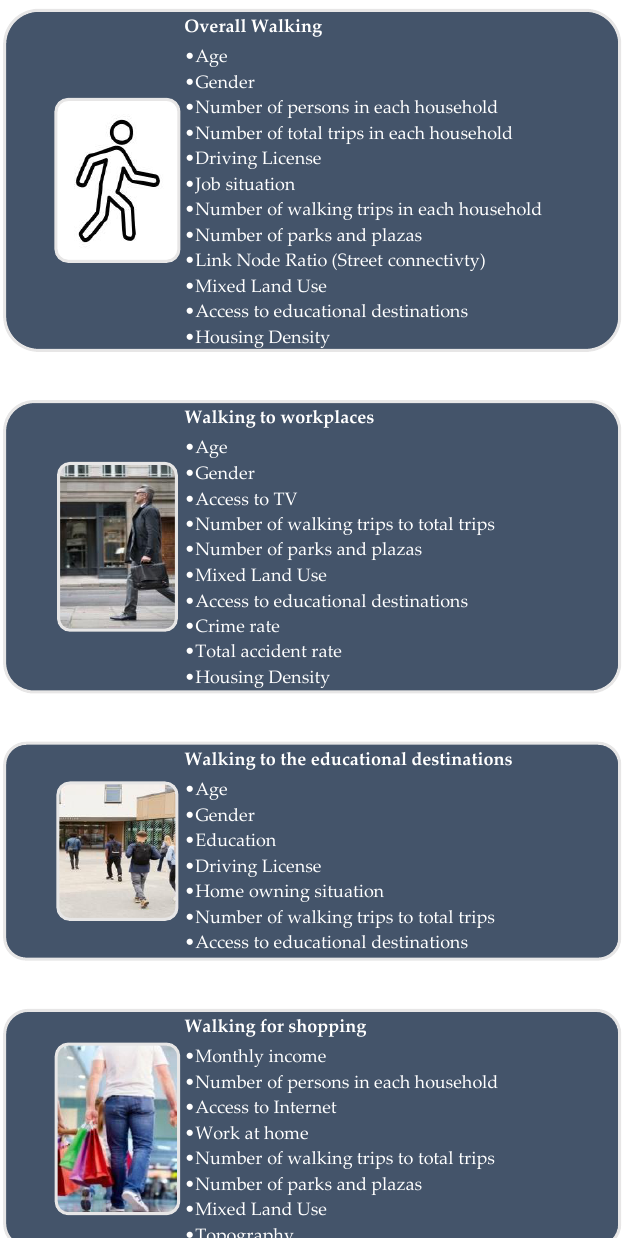
Figure 2. The summary of the correlated factors to overall walking and the three types of walking, including walking to workplaces, walking to reach the educational destinations, and walking for shopping (Pictures taken from https://www.vecteezy.com; https://www.drweil.com; https://www.thecompleteuniversityguide.co.uk; https://www.justlovewalking.com/. All the mentioned websites were accessed on 30 April 2022.)